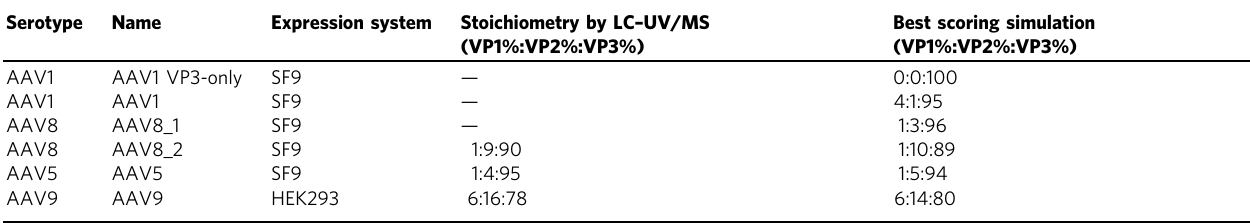
Table 1 Overview of analyzed AAV samples. Serotype